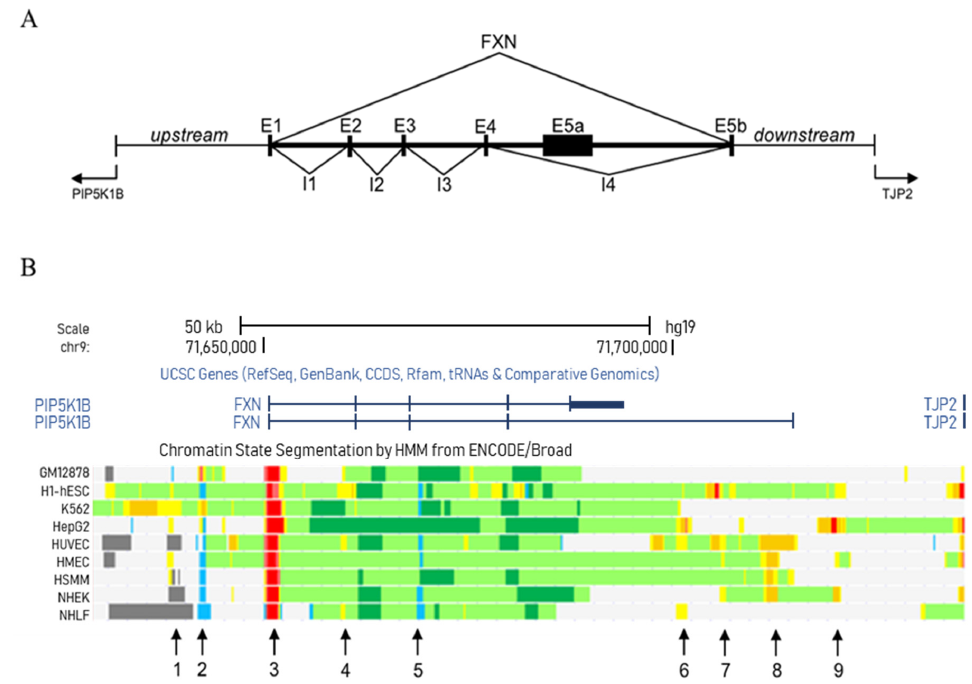
Figure 2. Chromatin states in the FXN genomic locus based on ENCODE data. All data were collected from the ENCODE database [46] and visualized in the University of California Santa Cruz browser (https://genome-euro.ucsc.edu). ( A ) Frataxin genomic locus spanning from the 3´end of the upstream gene (PRKACG) to the 5´end of the downstream gene (TJP2) (chromosome 9, 71629000-71736300 region); ( B ) Chromatin states across the FXN genomic locus, in which we can highlight nine regions: regions 1 and 2 (within the 5´UTR), region 3 (promoter zone), regions 4–8 (introns) and region 9 (3´UTR). Abbreviations: Ex, Exon x; Ix, Intron x; UTR, Untranslated Region. Table 1. Putative regulatory regions in the FXN genomic locus and associated chromatin state provided by ENCODE.